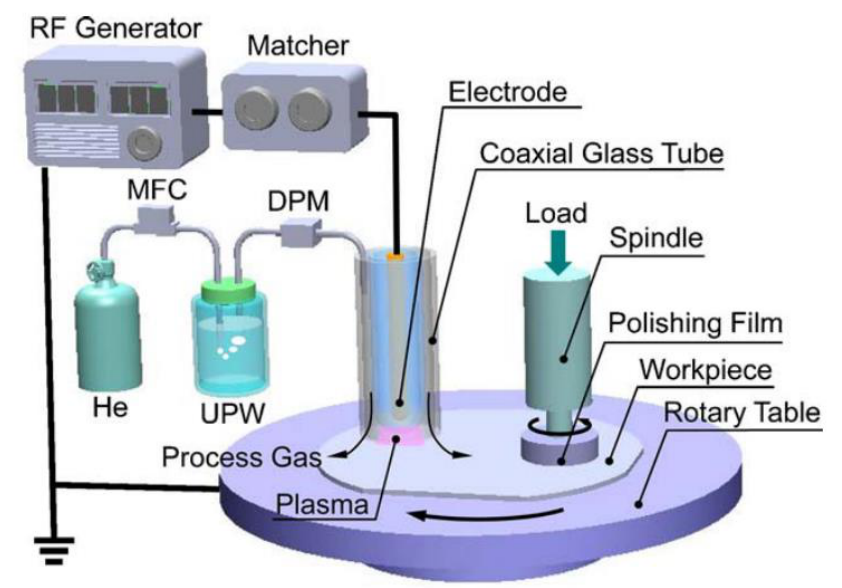
Figure 13. Schematic of PAP setup [37].